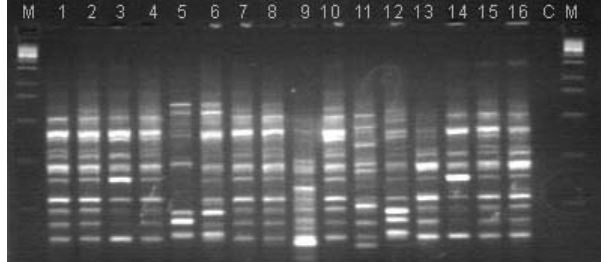
Fig. 1. PCR amplification products obtained with primer S 103, Lane M indicates standard DNA ladder of 100-bp marker and 1-16 indicates Cf-65, Cf-60, Cf-254, Cf-254m, Cf-223, Cf-250, Cf-249, Cf-255, Cf-248, Cf-253, Cf-256, Cf- 252, Cf-204, Cf-241, Cf-251 and Cf-245 respectively, C indicates control Tab. 5. Primers used in RAPD analysis of isolates of Colletotrichum falcatum Primer S. No.